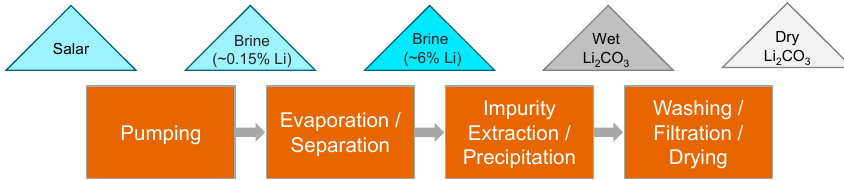
Figure 40. Simplified flow sheet for production of lithium carbonate from brines.